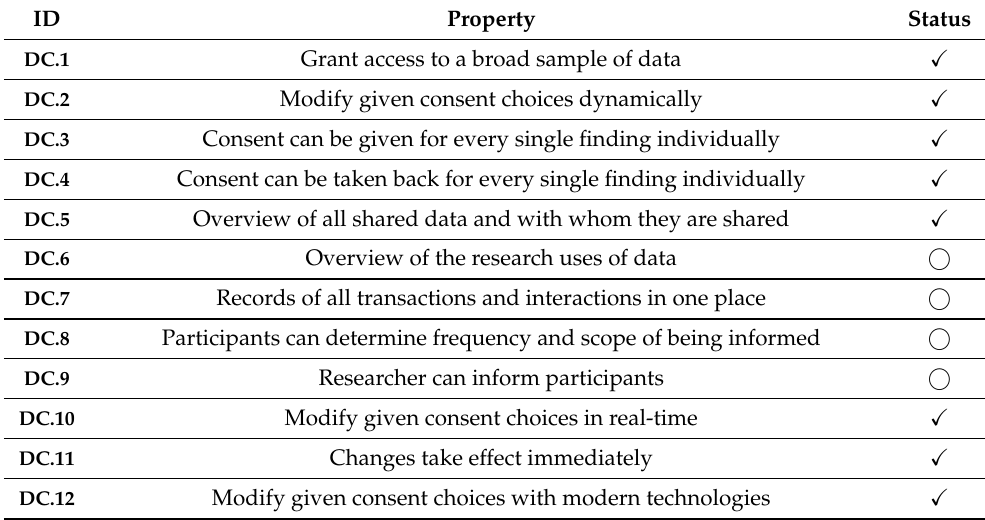
Table 5. Evaluation of Dynamic Consent properties.